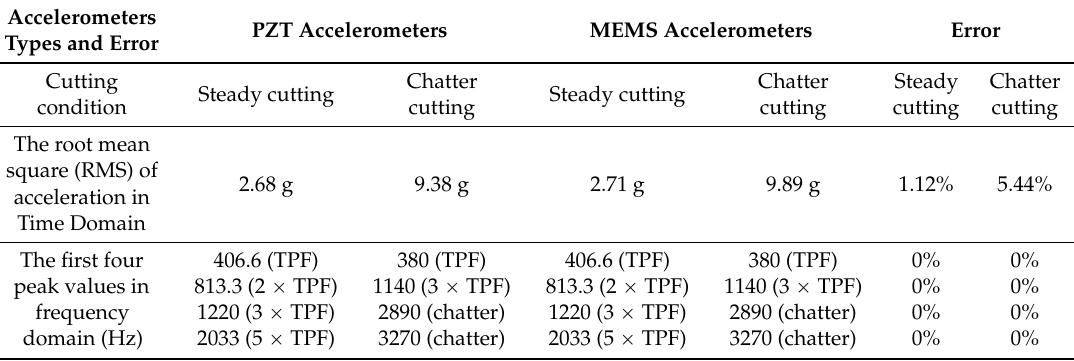
Table 1. The comparison of measurements in time and frequency domain between piezoelectric and MEMS accelerometers in cutting experiment. PZT: lead zirconate titanate; MEMS: micro electro mechanical systems; TPF: tooth-passing